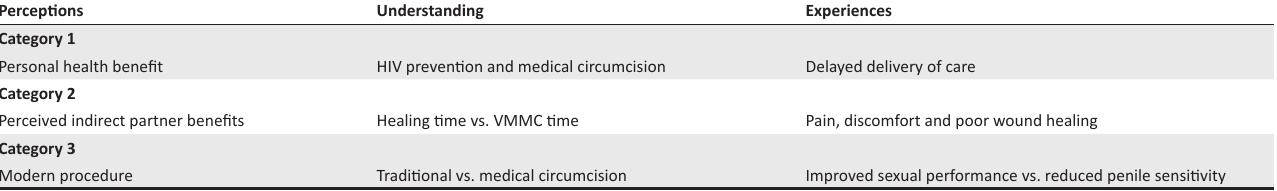
TABLE 2: Summary of categories of description emerging from participant interviews.